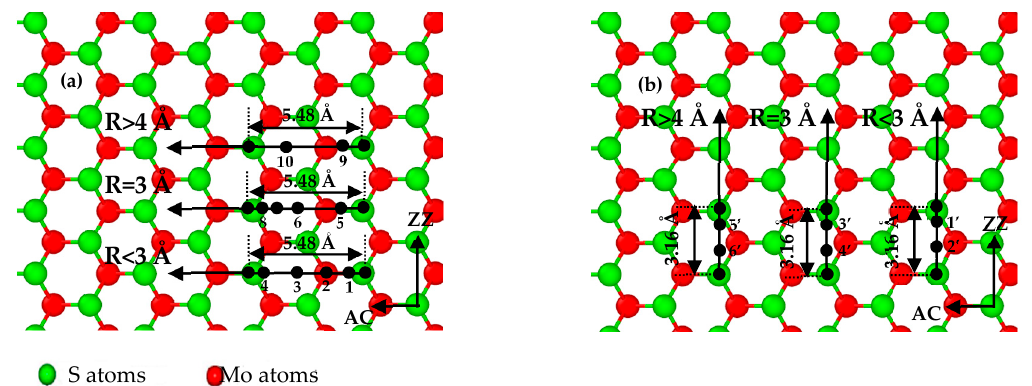
Figure 4. Sliding paths in various lattice orientations: black points are extreme points at frictional force–sliding distance curves in a single periodic length of ( a ) 5.48 Å for the AC orientation and ( b ) 3.16 Å for the ZZ orientation of SLMoS 2 film.